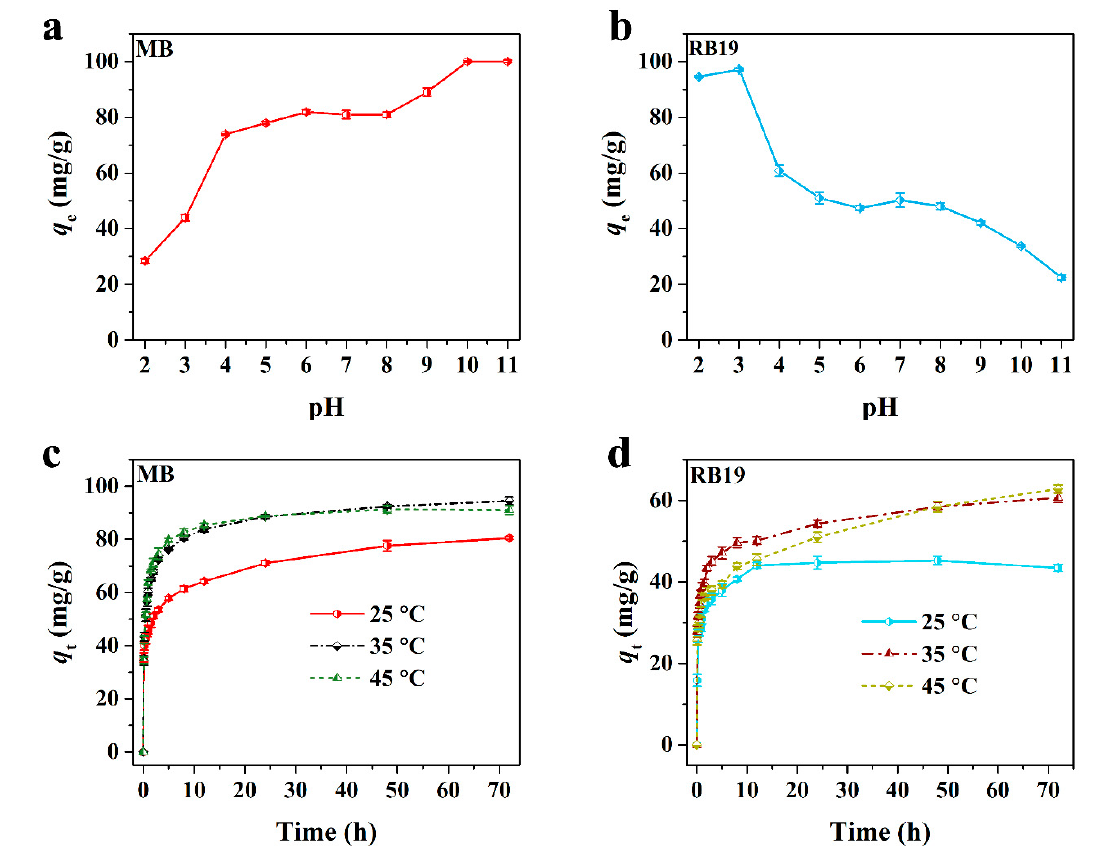
Figure 3. Effect of initial solution pH on ( a ) MB and ( b ) RB19 adsorption onto N ‐ CM (at 25 °C for 72 h). Contact time effect on ( c ) MB and ( d ) RB19 adsorption onto N ‐ CM (in natural pH aqueous solution).